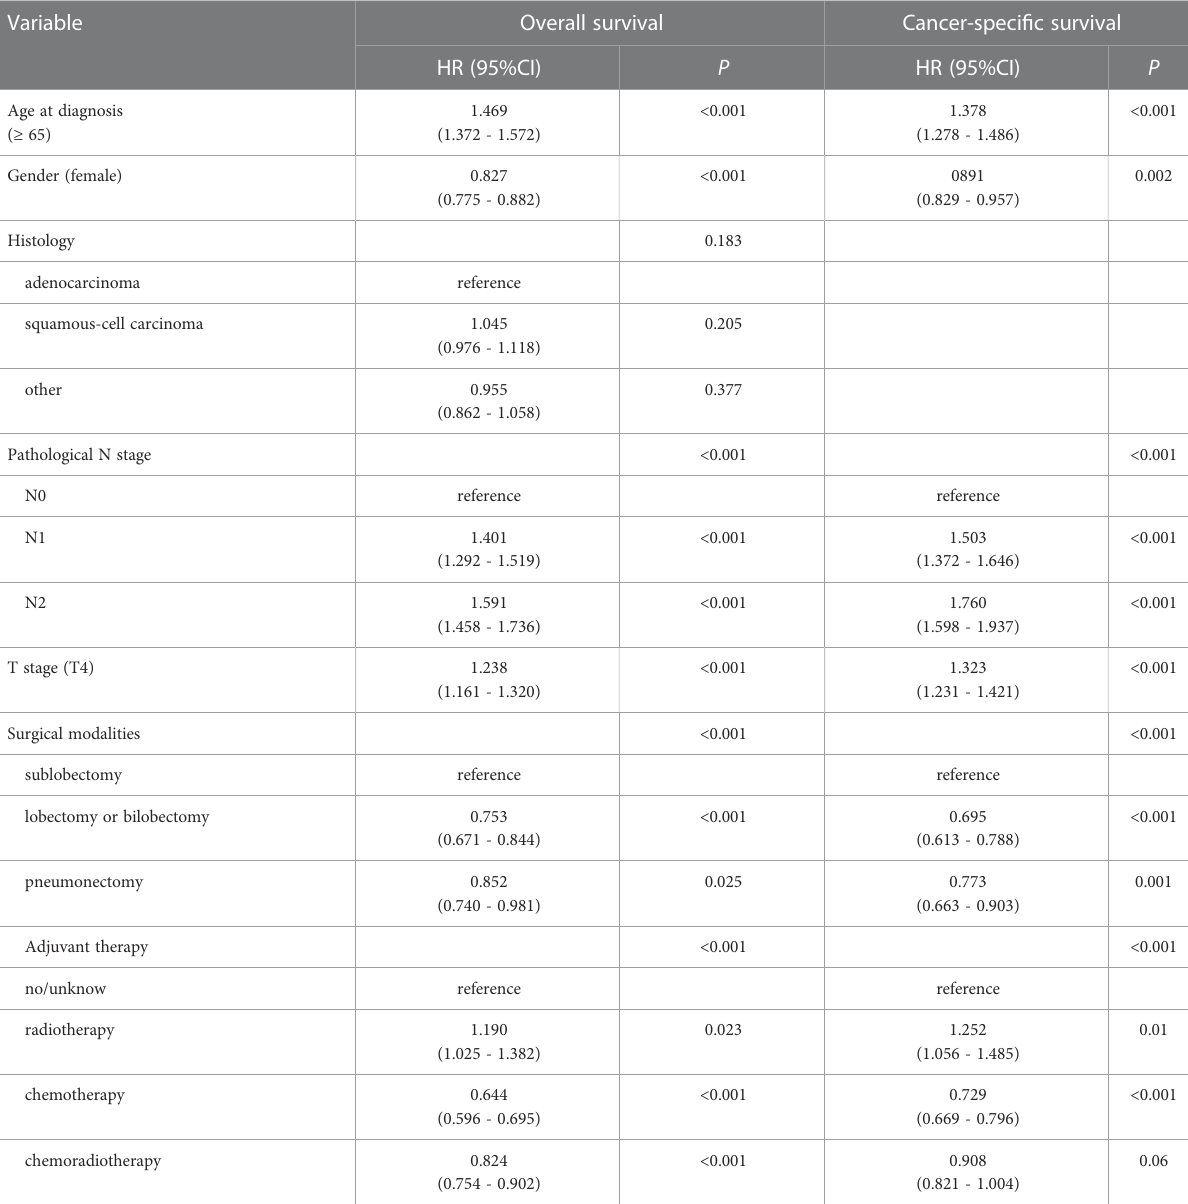
TABLE 3 Multivariable Cox regression analysis for overall survival (OS) and cancer-speci fi c survival (CSS) of all patients